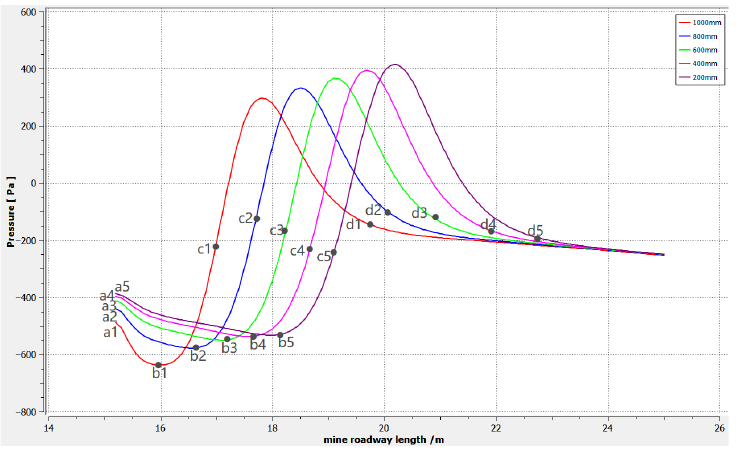
Figure 6. Air-pressure variation curve of roadway-length direction at the leeward side of personnel door.